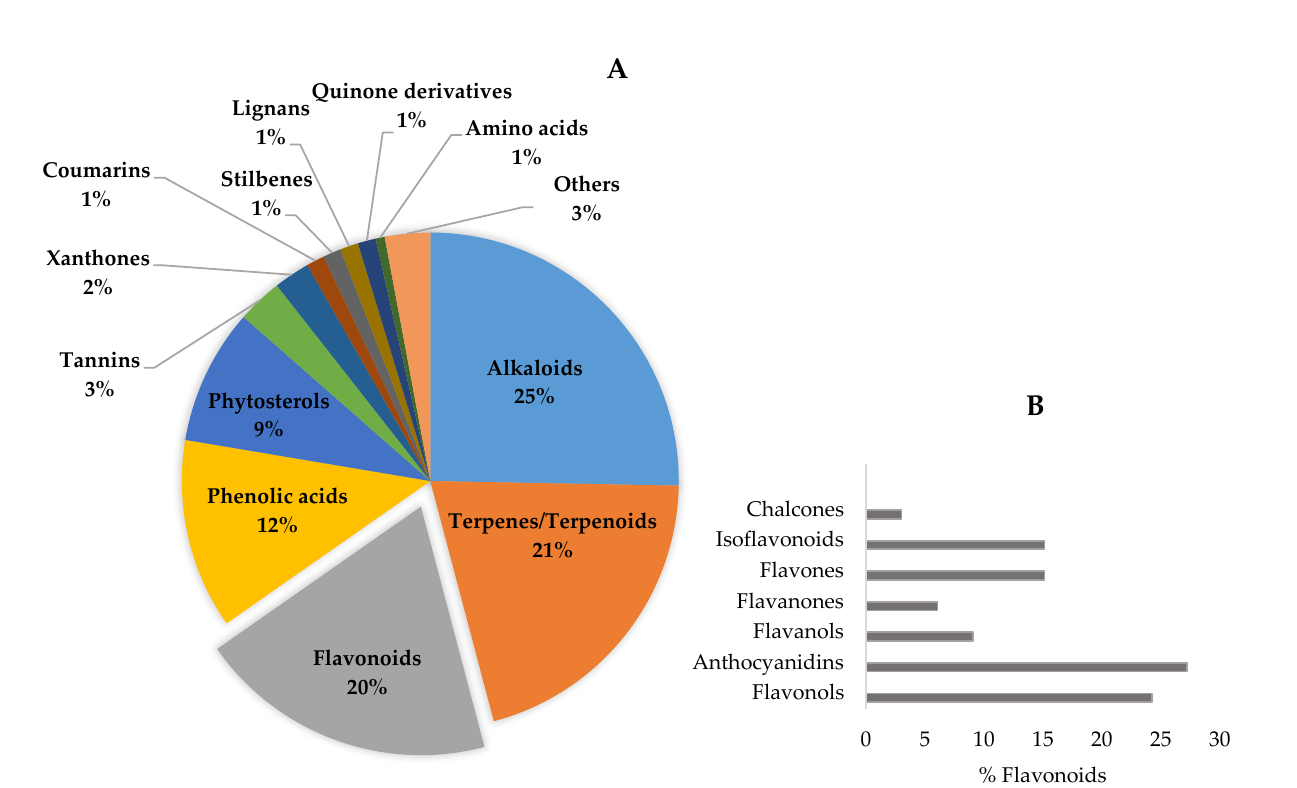
Figure 4. Phytochemicals in botanicals for cognitive enhancement ( n = 170) by chemical class, evidencing the contribution of flavonoids ( A ). Phenolic compounds represent 42% of the total. On the inset ( B ), the relative percentage of the different types of flavonoids is